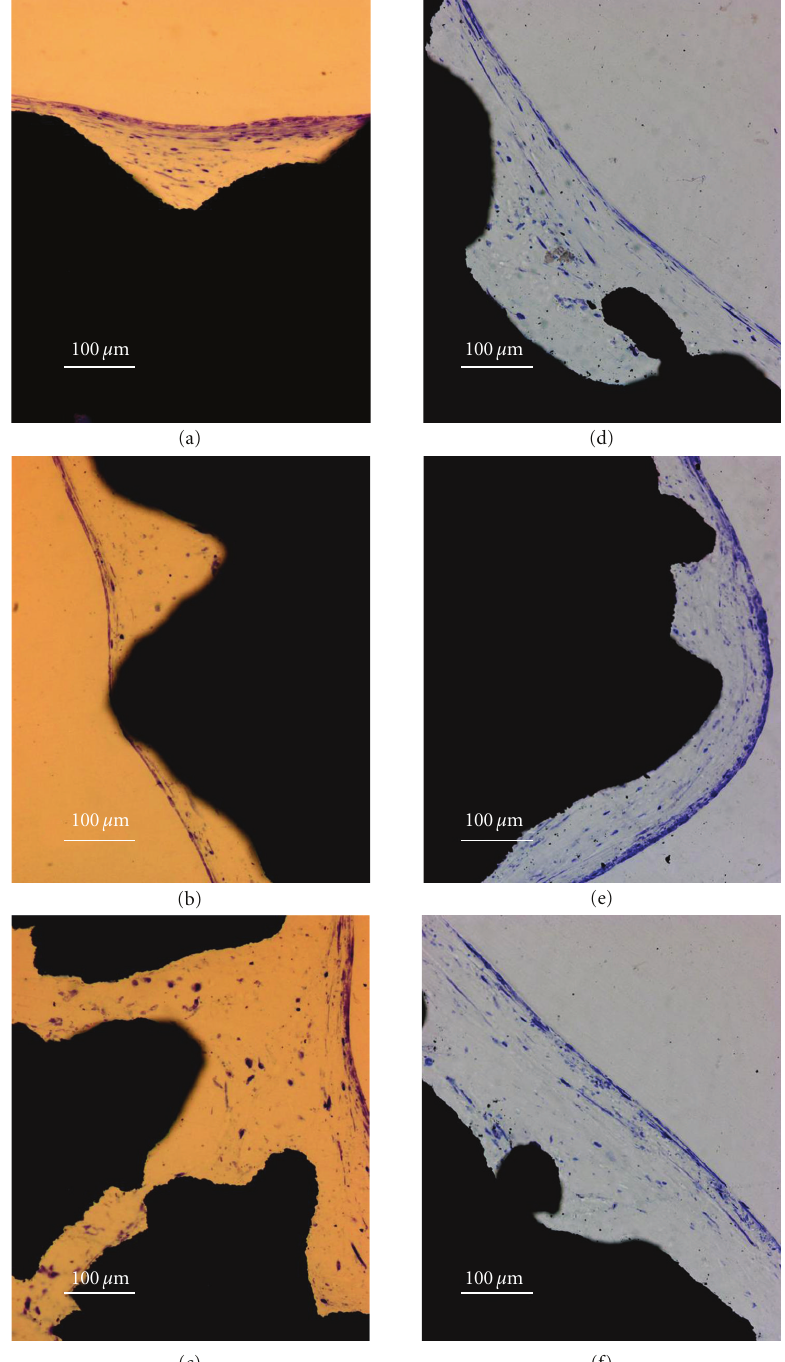
Figure 7: Histological micrographs of cp-Ti (a–c) and Ti6Al4V (d–f) constructs stained with toluidine blue; scale bar = 100 μ m.